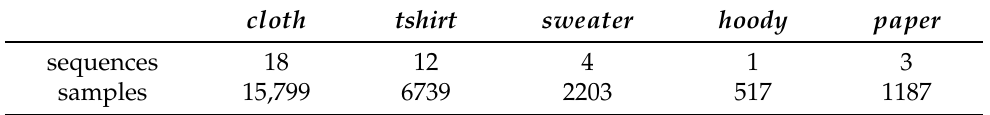
Table 2. Summary of objects in the textureless surfaces dataset [3]. Sequences of data samples were captured using a Kinect device at 5 FPS with varying lighting conditions across sequences. cloth tshirt sweater